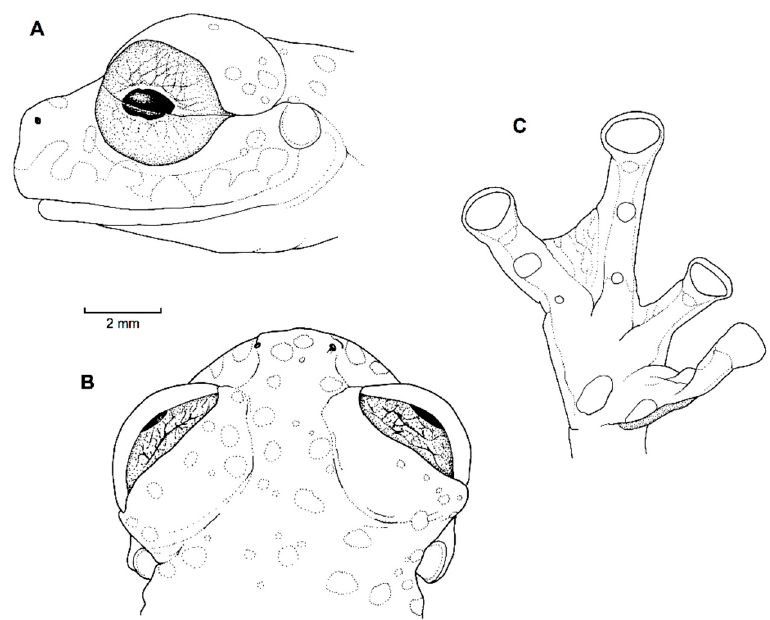
Figure 199. Sachatamia albomaculata , adult male, QCAZ 4325. ( A ) Head in lateral view. ( B ) Head in dorsal view. ( C ) Hand in ventral view. Illustrations Juan M. Guayasamin.